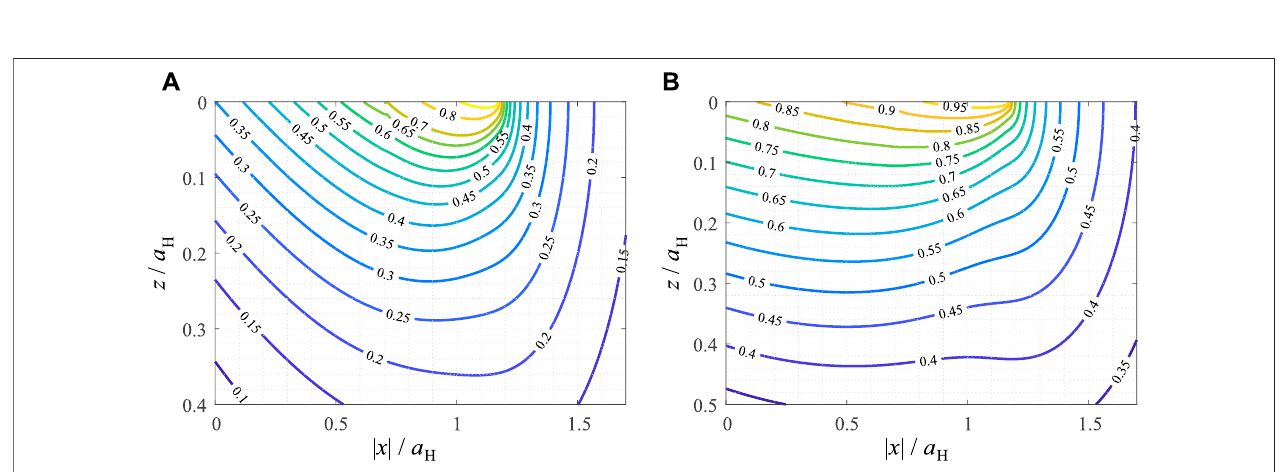
FIGURE 4 | Contour line diagrams of critical plane fatigue crack initiation criteria, normalized for their maximum values, in the loading plane for the plane partial slip limiting wear pro fi le under oscillating tangential load. (A) Smith-Watson-Topper parameter (B) Findley parameter.